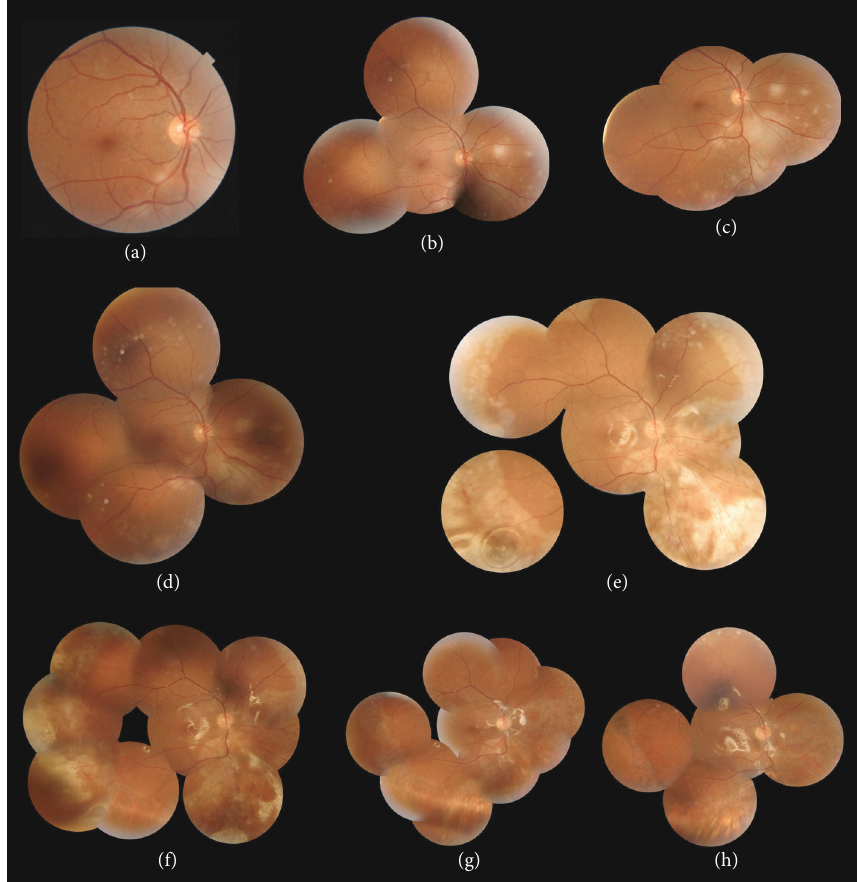
Figure 1: (a) Fundus photograph of the right eye (OD) at presentation shows white necrotic patches in the vicinity of the inferior arcade. (b) Montage fundus photograph of OD on day 4: retinal lesions progressed, intravenous acyclovir dosage was increased to 850 mg three times per day, and the second dose of intravitreal ganciclovir (2 mg/0.1cc) was administered. (c) Three days later, despite medical treatment, the lesions continued to progress. (d) On day 10, lesions coalesced and showed an increase in size. (e) One day after pars plana vitrectomy with silicone oil tamponade and prophylactic endolaser. (f) One week after the right eye surgery (day 20). (g) One month after the right eye vitrectomy, the lesions regressed signi fi cantly. (h) Seven months after initial presentation, lesions near completely